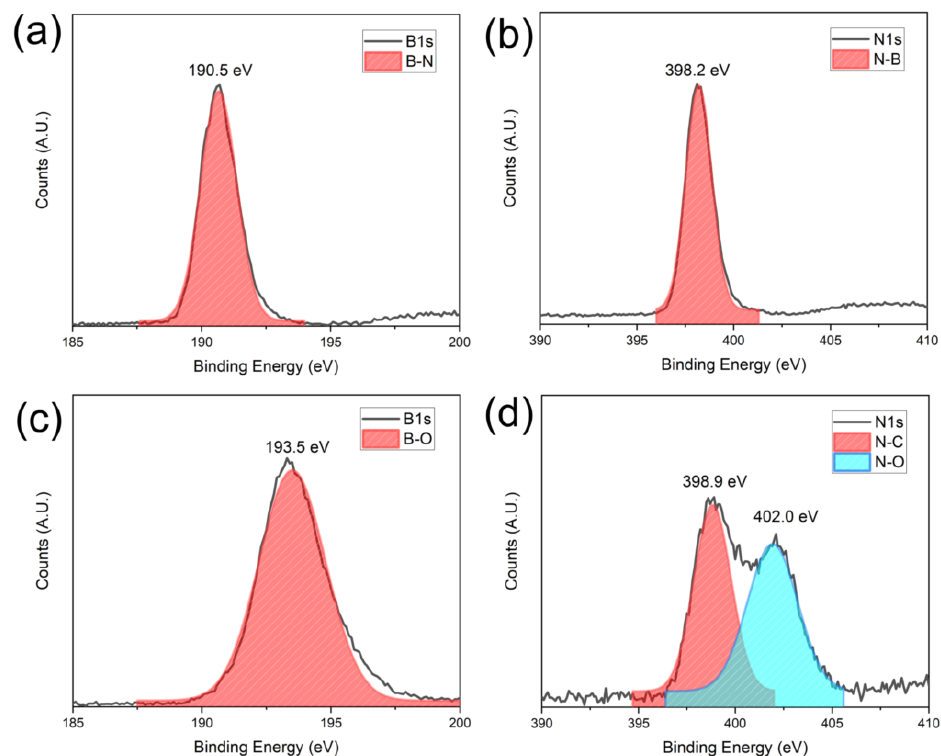
Figure 8. XPS signatures of the BNNS before and after AO exposure: ( a ) B1s and ( b ) N1s signal before exposure and ( c ) B1s and ( d ) N1s after